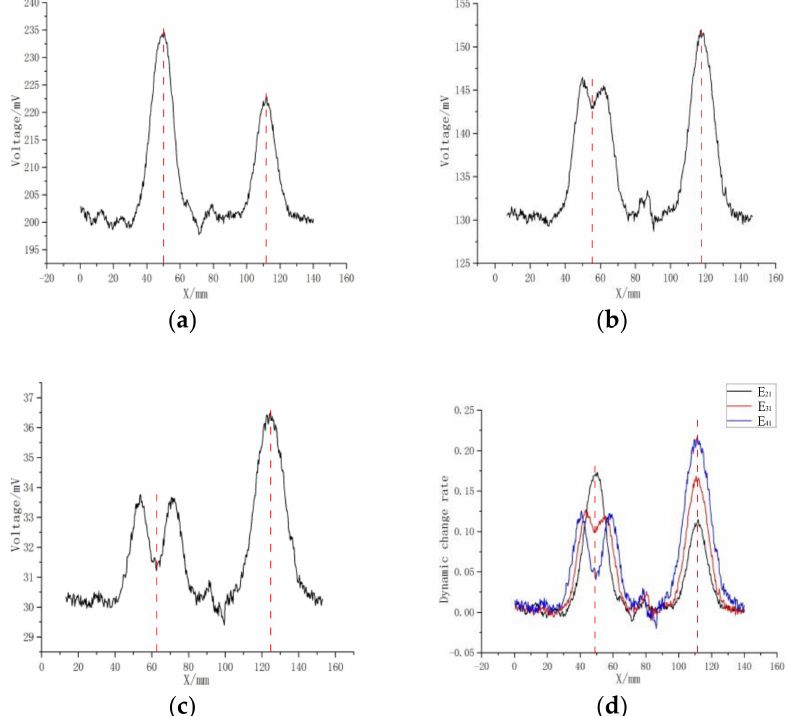
Figure 13. Experimental results: ( a ) the voltages of E21, ( b ) the voltages of E31, ( c ) the voltages of E41, ( d ) the DCRs of E21, E31 and E41.The dynamic change rate of E21, E31 and